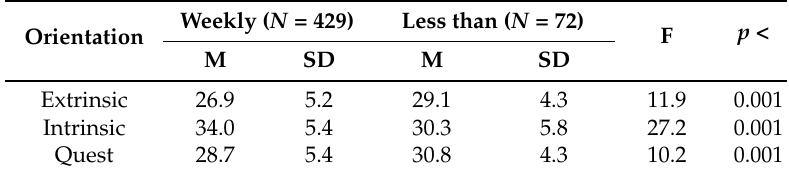
Table 2. Mean scale scores by church attendance.